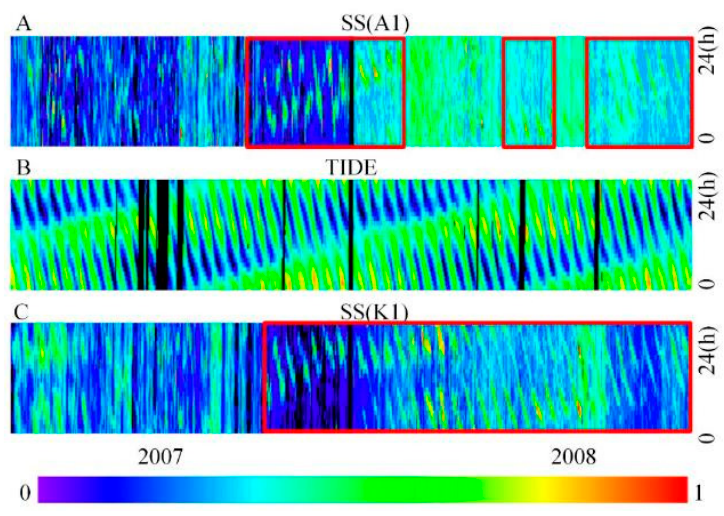
Figure 8. Raster image of suspended sediment (SS) at stations A1 ( A ) and K1 ( C ) and tide ( B ) in 2007 and 2008. The row of each part represents the 24 h in a day and the column of each image covers the 731 days of two years of measurements. The color denotes the normalized value and black sections represent missing data. Data in red frames show measurements of SS at each station that have a highly similar temporal pattern to the tides. Table 2. Cross-correlation results between suspended sediment concentration (SSC) and the tide.